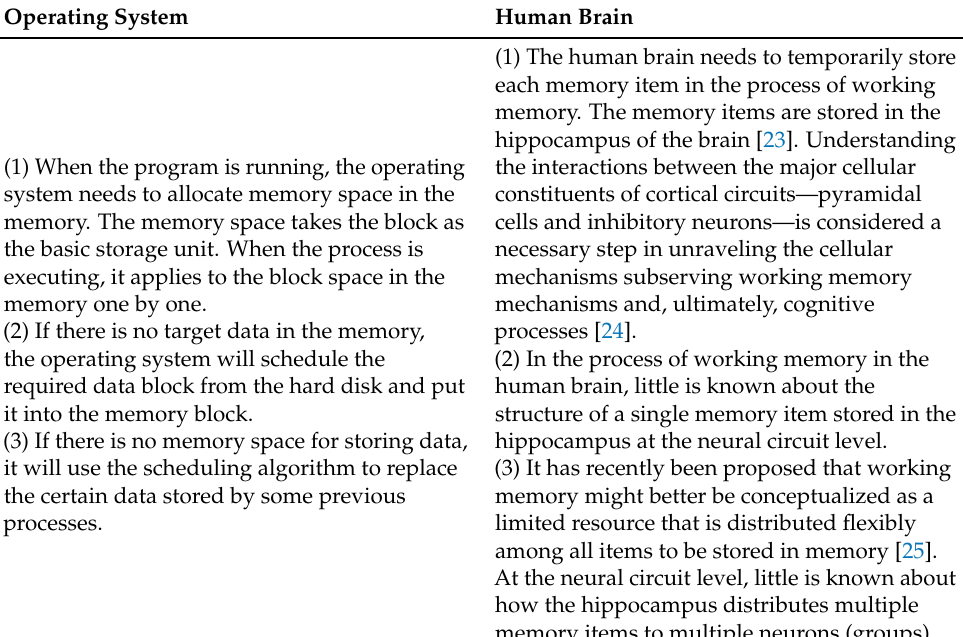
Table 1. Comparison between the process of memory management in computer operating system and the process of working memory in the human